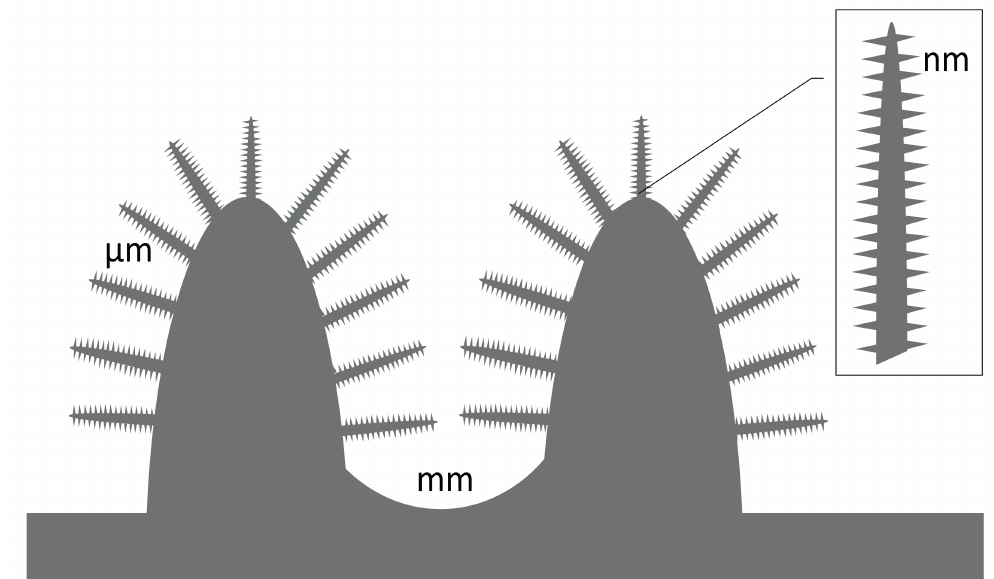
Figure 4. The hierarchical structure of a typical implant surface includes different levels of roughness. The morphology of each dimension is dependent from the material composition, the manufacturing process and post processed changes. Defined rose stock, brush-like or multi-spike topographies showed osteoconductive and bactericidal properties. It is hypothesized that these bioinspired nanospikes designs will deform or rupture the bacterial cell wall and lead to death (physical killing mechanism)